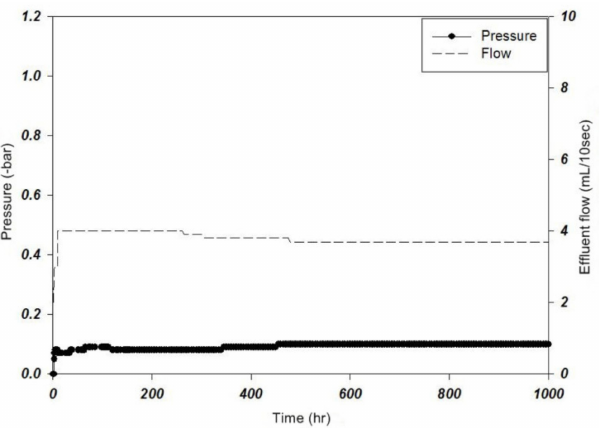
Figure 5. TMP profile and flux of MBR with intermittent aeration (20 min aeration and 40 min non-aeration).